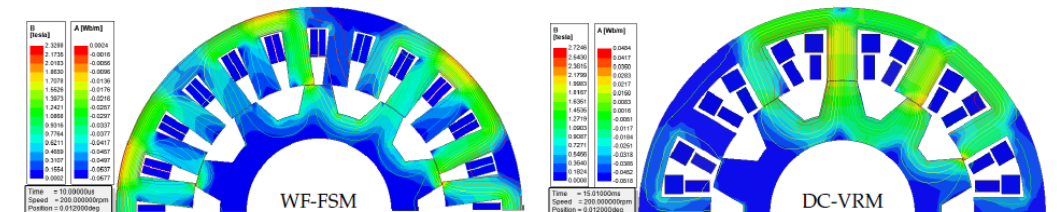
Figure 11. Three-phase WF-FMM models in transient 2D-Ansys–Maxwell showing flux density and lines distribution at rated currents (phase and field) and given rotor position. Phase/DC slots ( left ) 24/24 WF-FSM and ( right ) 12/24 DC-VRM.